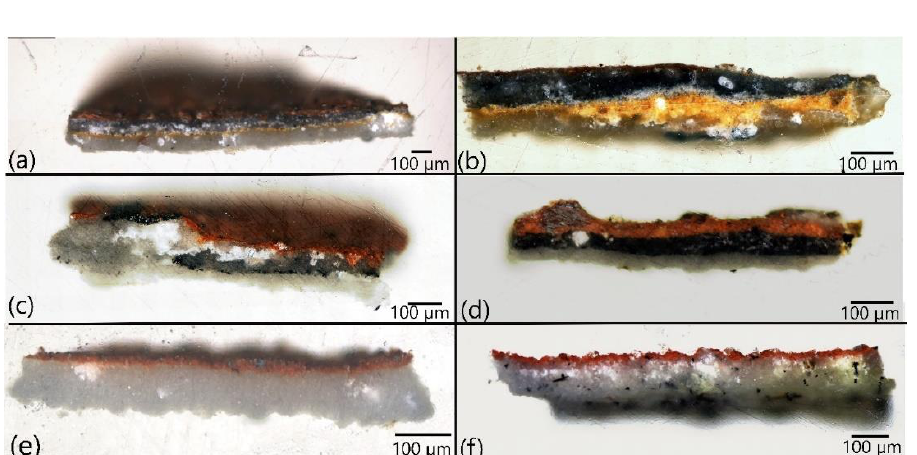
Figure 4. Optical images of cross-sectional samples from Heddal and Eidsborg, showing typical stratigraphy: ( a ) H1a, ( b ) H1b ( c ) H1d, ( d ) E1c, ( e ) E1d, and ( f ) E2a. Sample names correspond with